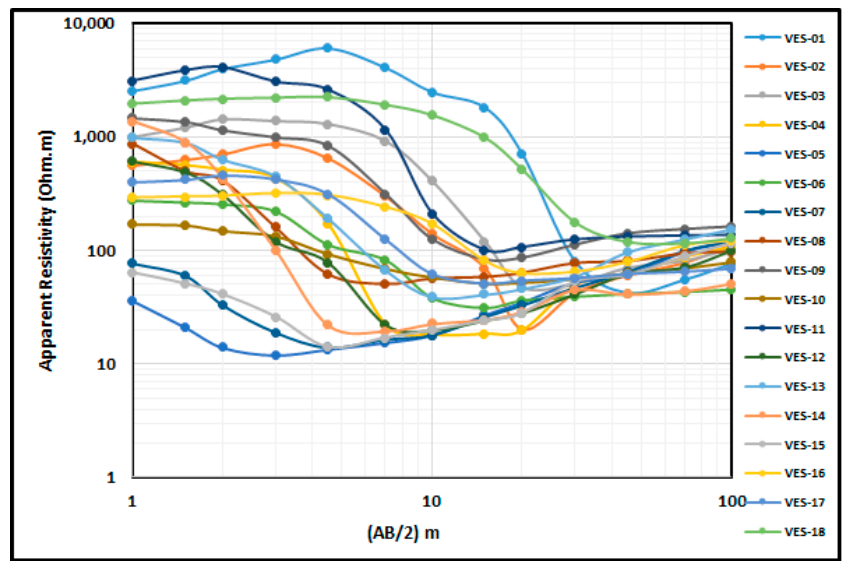
Figure 11. Acquired vertical electrical soundings throughout the study area. Two contour maps of apparent resistivity at electrode spacings (AB/2) equal to 1 and 30 m were constructed for analyzing the areal distribution of apparent resistivity at different levels, which can perform a preliminary impression of the apparent resistivity